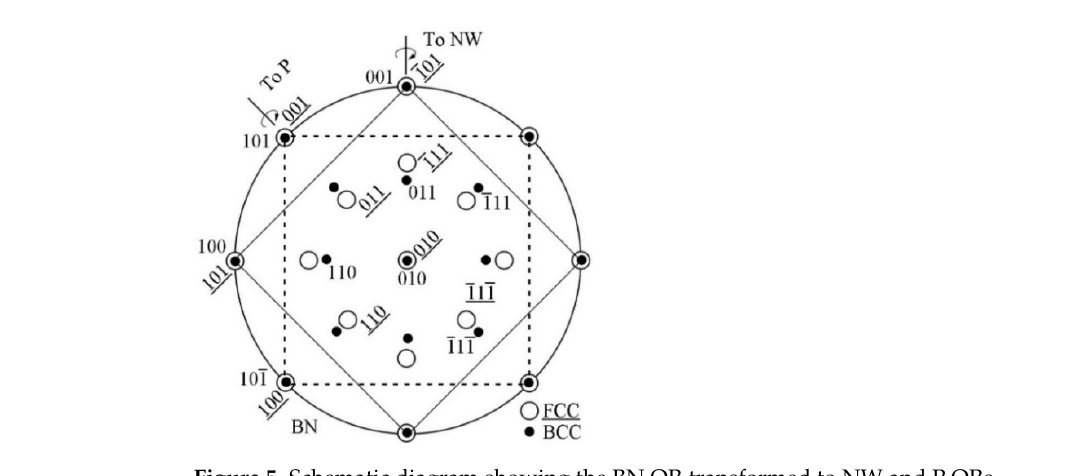
6 of 14 Figure 4. Schematic diagram showing BN 1a transferred to four NW OR variants by rotation axis. The P OR was first discovered during the transformation of austenite to martensite in microalloyed steel with nitrogen addition, and was also observed in precipitates and matrix systems. For example, it was observed in Cr-rich precipitates and Cu matrix in Cu- Cr alloy, Cr-rich precipitates and Ni matrix in Ni-Cr alloy, α -Fe precipitates and Cu ma- trix,